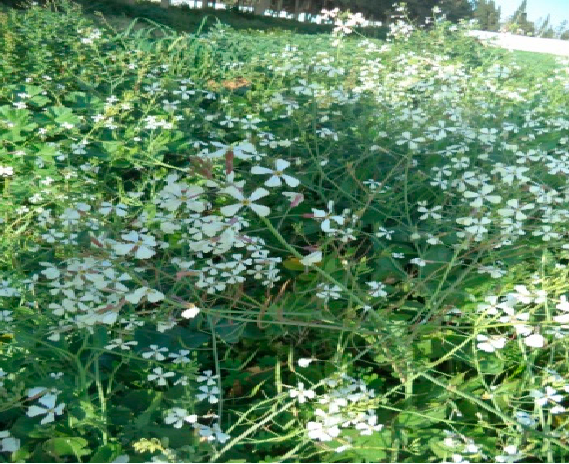
Figure 5. General aspect of Raphanus raphanistrum.